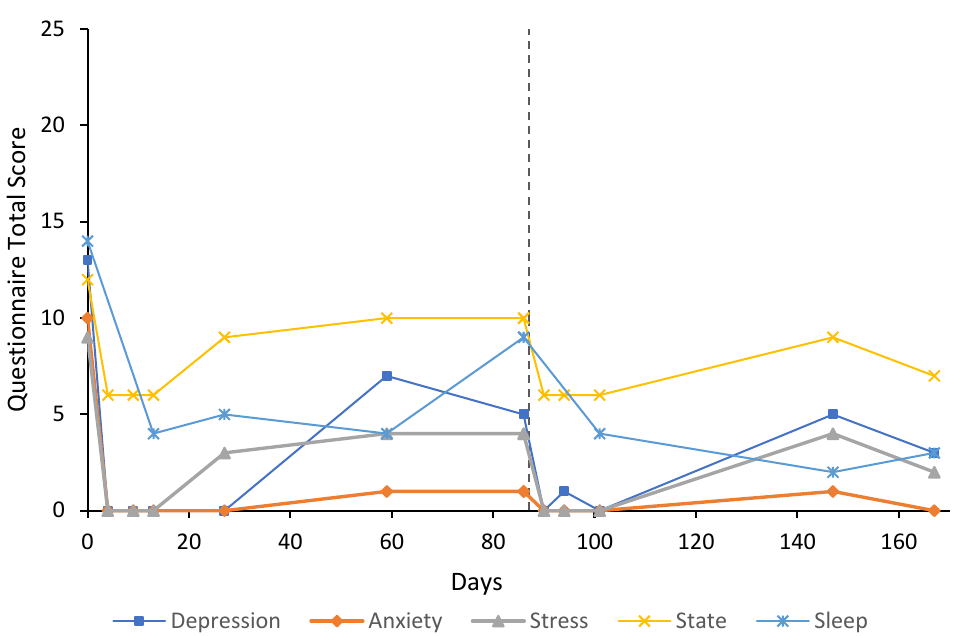
Figure 8. Line graph showing Case 8 results from the DASS-21 (depression, anxiety, and stress subscales), SSAI-6, and JSS at each follow-up. The participant was treated with an eight-day flumazenil infusion and re-treated on day 87 with a four-day flumazenil infusion (denoted by a dashed line).